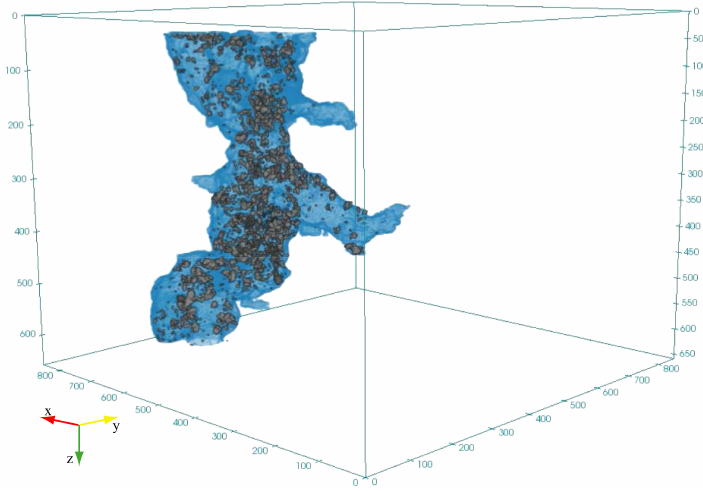
Figure 12. 3-D image of the formed wormhole (blue) and initial non-connected porosity presented in the final wormhole feature (grey).